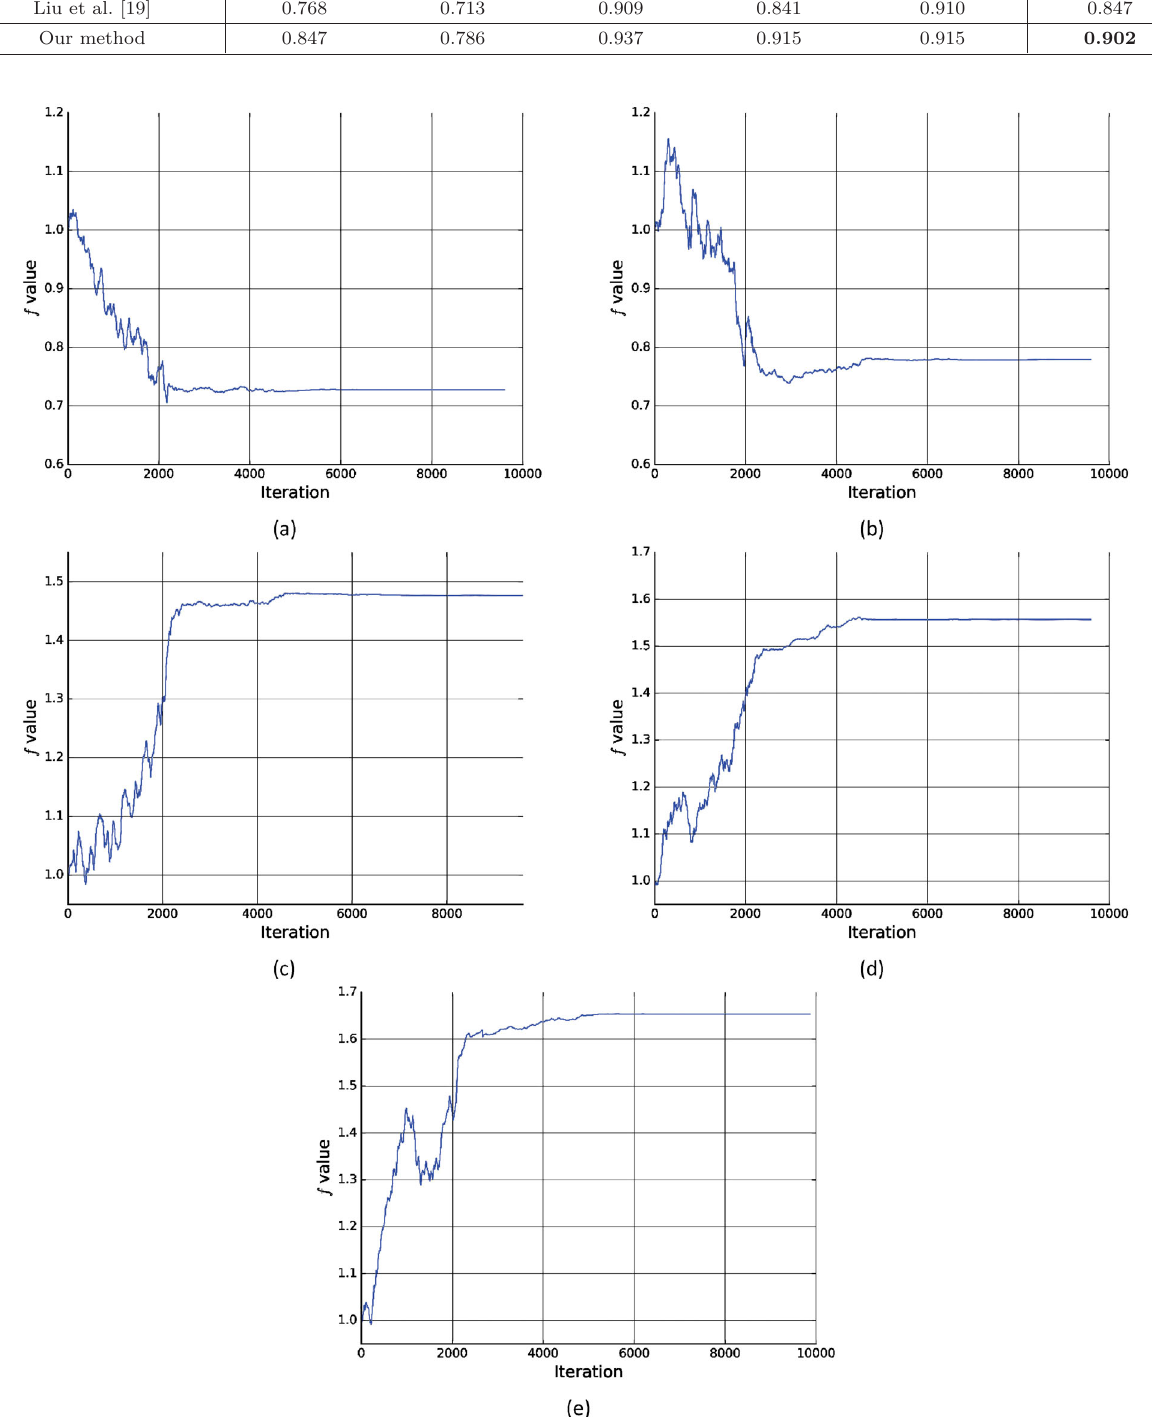
Fig. 5 Typical fluctuations in f during training for the general image parsing task. Modified models used initial dilation values of: (a) 4, (b) 6, (c) 16, (d) 18, (e) 20. Unlike the training process for the face parsing task, f shows more noticeable fluctuation due to high data variability in the VOC